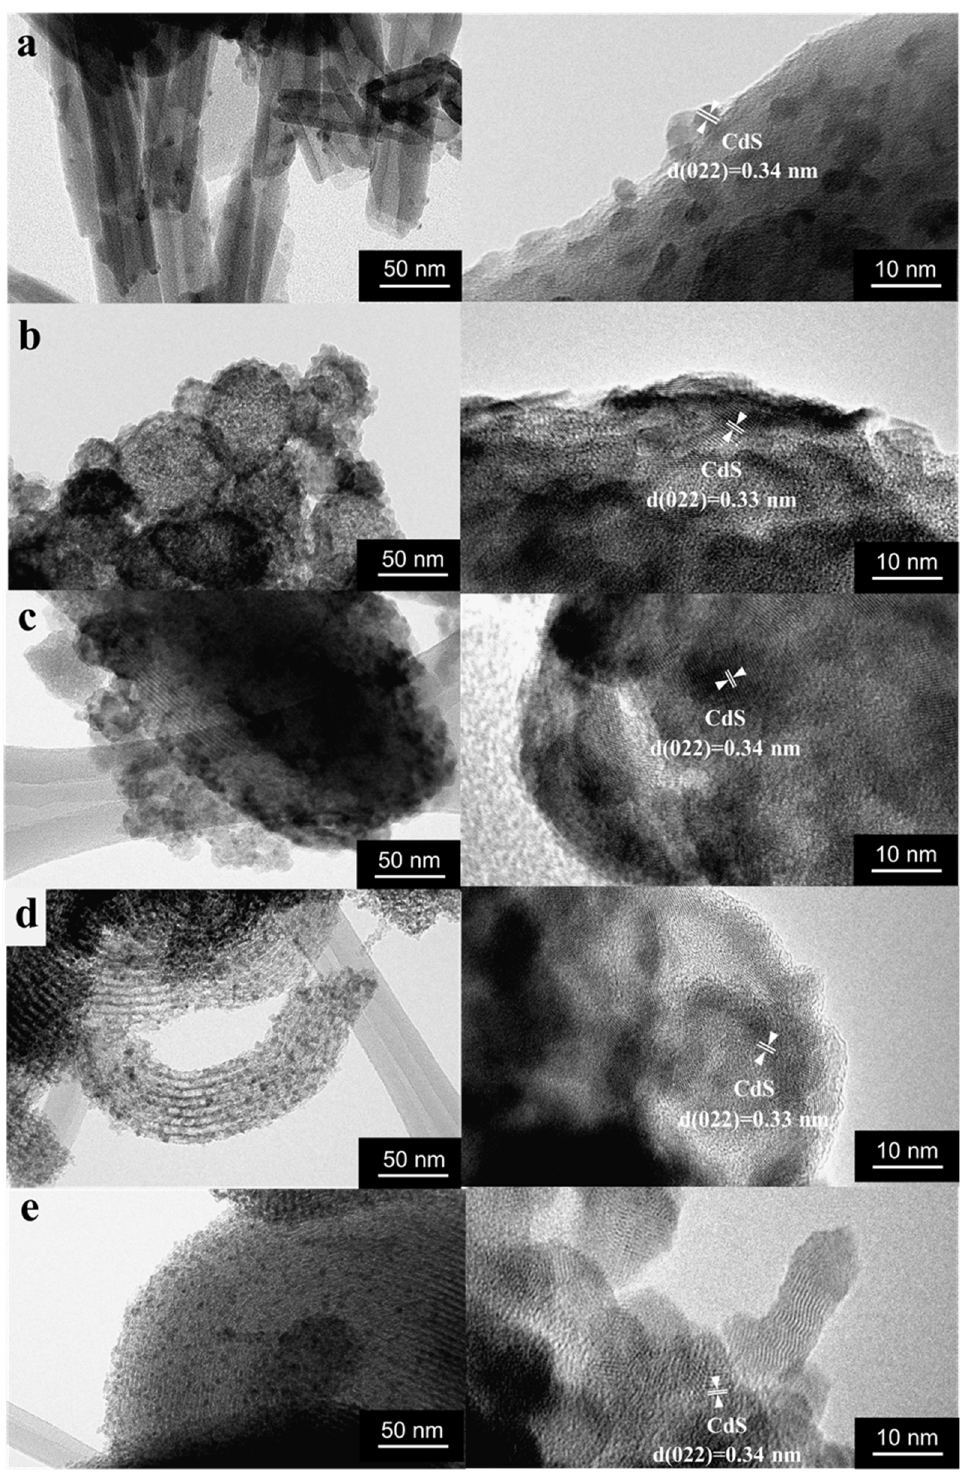
Figure 2. TEM under different magnifications of CdS/HNTs ( a ), CdS/MCM-41 ( b ), CdS/MCM-41- HNTs ( c ), CdS/SBA-15 ( d ), CdS/SBA-15-SH ( e ).